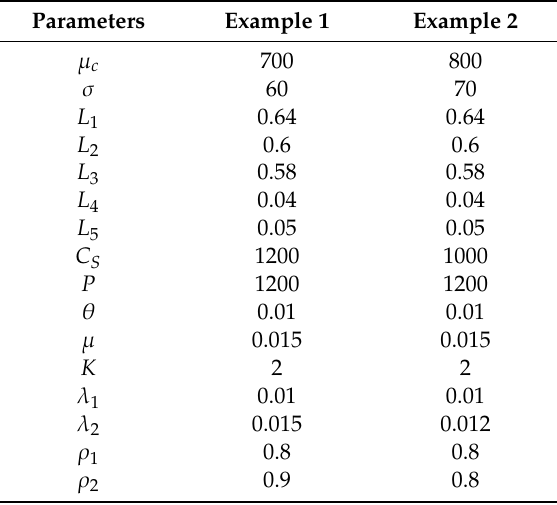
Table 2. Numerical